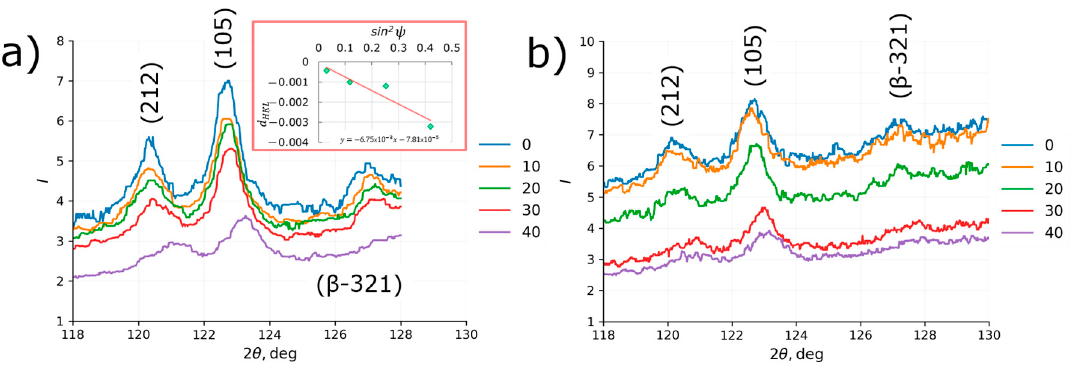
Figure 7. X-ray diffraction spectra collected for ψ = 0, 10, 20, 30, and 40 degrees from X-ray 1 specimen aligned along the sample’s ( a ) x axis and ( b ) y axis. Inset is a plot of d HKL vs. sin 2 ψ linearization plot. The data on peak shift and estimates of residual stresses for two ( hkl ) crystallographic directions in α -Ti and one ( hkl ) in β -Ti phases are accumulated in Table 1. Compressive residual stresses along both x and y sample’s axis as strong as − 1000 MPa have been detected at both sides of the sample where the shot peening treatment was applied—shot peening gives good uniformity and reproducibility of treatment. Compressive residual stresses along (212) direction seem to be at least 30% stronger than those along the